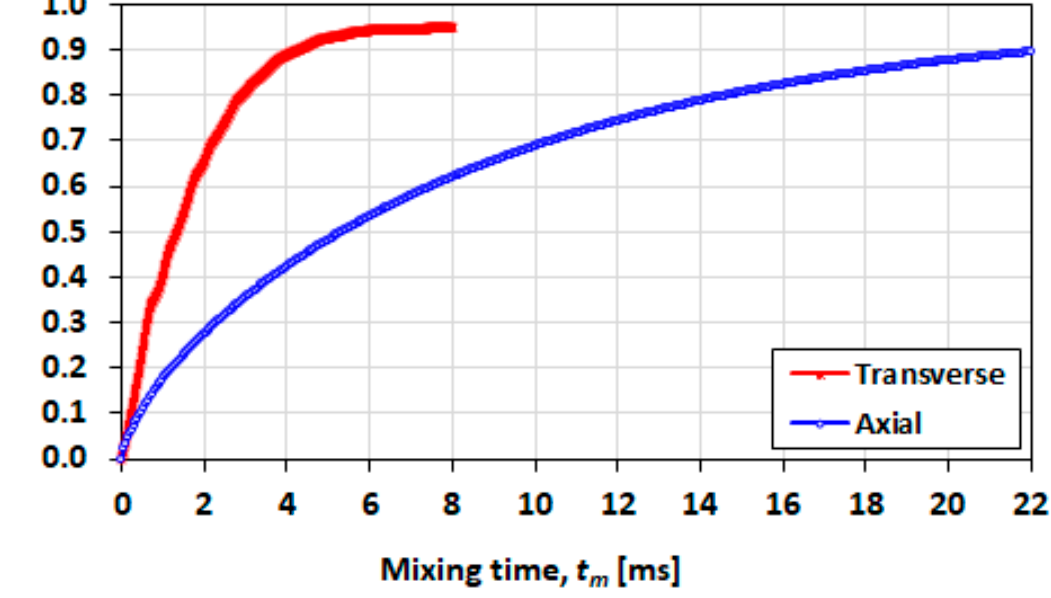
Figure 22. Effect of the initial mixing orientation on the mixing index for a droplet with initial length of L 0 = 2 h , Ca = 0.21 and λ = 0.5 .